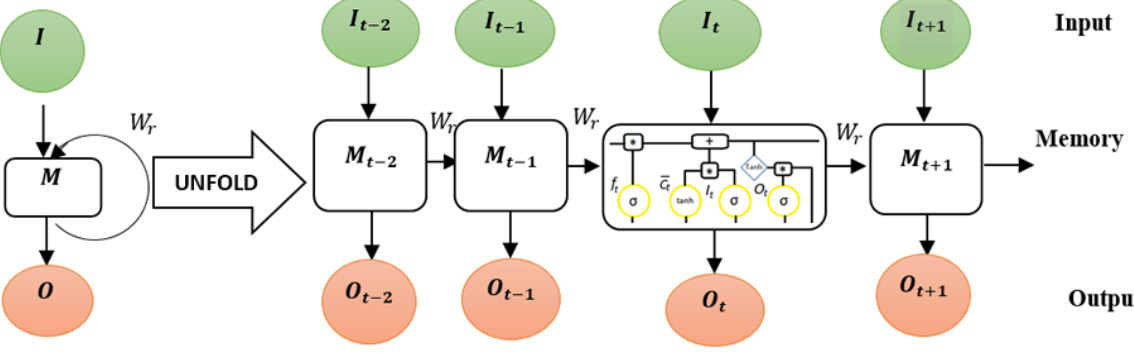
Figure 7. Long short-term memory representation for output sequence influence by input sequence and previous output. Where It-2 and It-1, Ot-2 and Ot-1, Mt-2 and Mt-1 are inputs, outputs, memory respectively for previous time steps. It, Ot, and Mt are the current input, output and memory state of the LSTM cell. Ot+1, and Mt+1 represent subsequent output and memory state respectively for subsequent time step input It+1. I, O, M represent the recurrent input, output and memory state respectively for a simplified LSTM cell operation and Wr is the weight for the computation in the